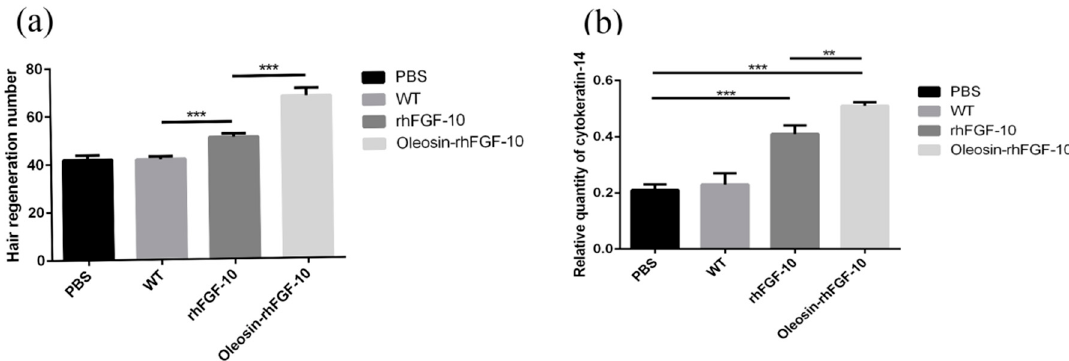
Figure 10. The number of regenerating hair follicles and expressing cytokeratin-14 were quantified. ( a ) Presenting the number of hair follicles; ( b ) the relative content ofcytokeratin-14. *** p < 0.001, ** p < 0.05.